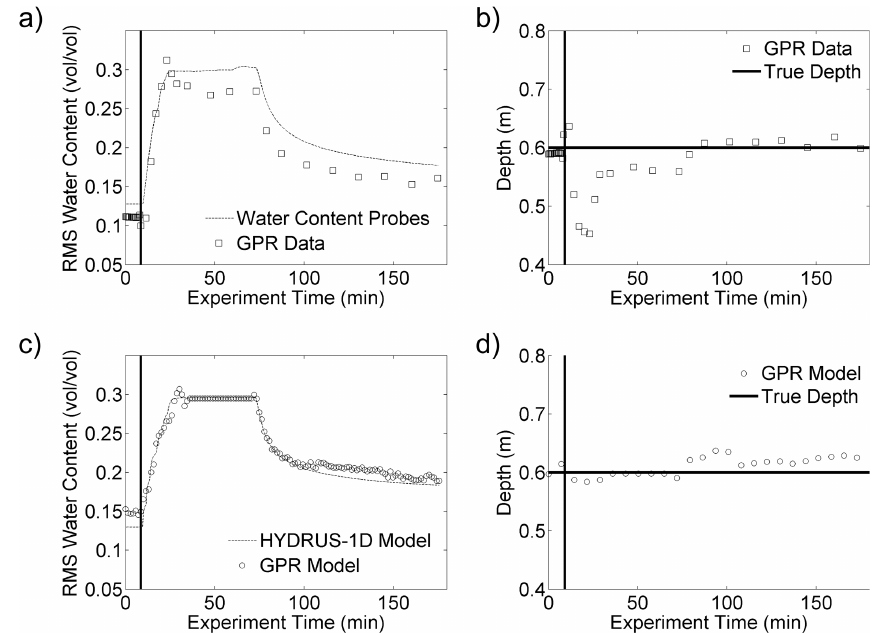
Fig. 7. (a, c) Average water content during the experiment estimated using the bottom of sand reflection in observed and simulated GPR data, moisture probes, and flow modeling with HYDRUS-1D. (b, d) Depth to reflector estimated from bottom of sand reflection for both GPR data and model. Vertical lines indicate the onset of